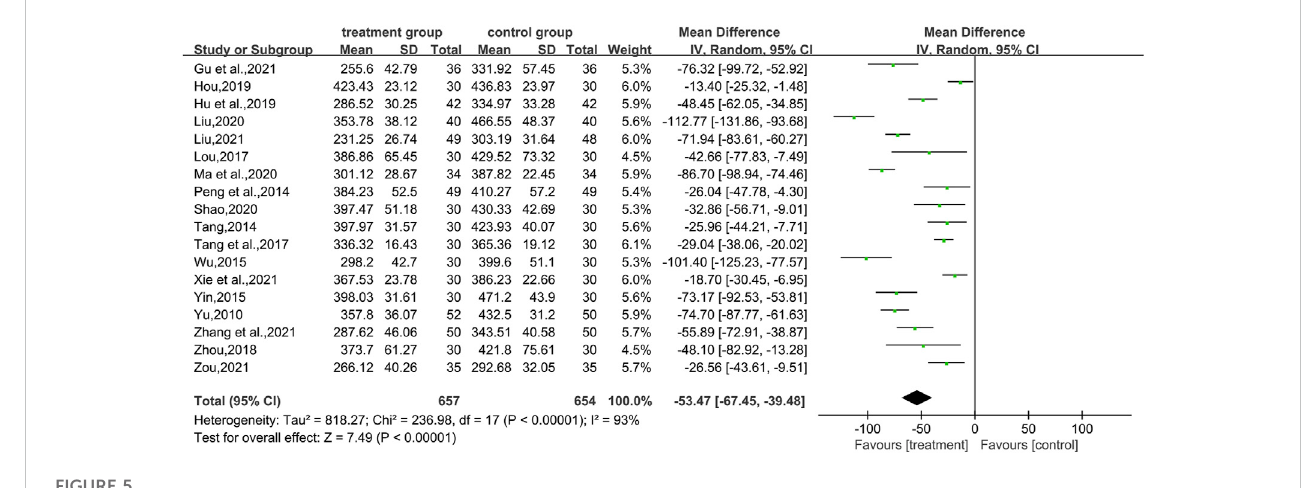
FIGURE 5 Forest plot for uric acid.